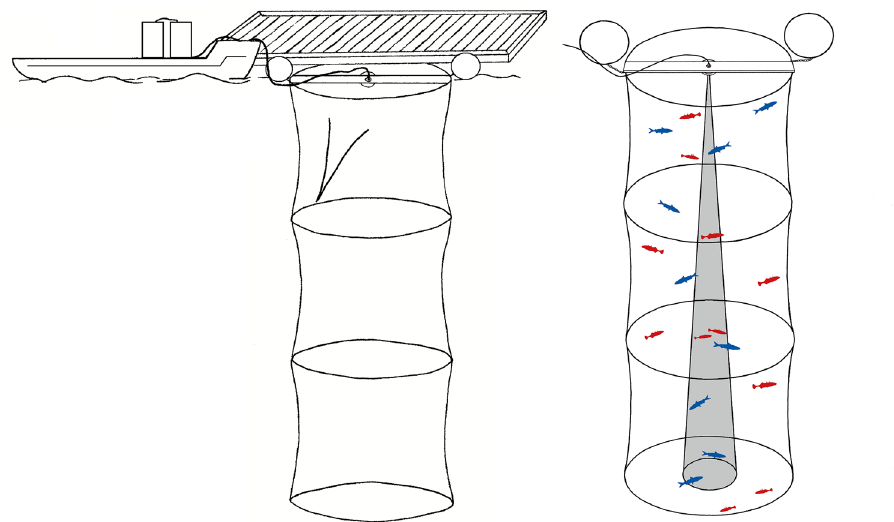
Figure 1. Left: experimental setup including boat with two tanks where the EK 80 wide band transceiver and a laptop were stored during the experiment and the mesocosm (6 × 2.3 m) attached to a floating pontoon. Right: mesocosm stocked with free swimming whitefish (blue) and sticklebacks (red), which are depicted together but were sampled separately for data collection. The cone (in grey) represents the true to scale sound cone emitted by the ES-120-7C transducer with an opening angle of 7°. Note that fish are not true to scale due to their small size. Drawings by Leonie Kneipp, LKdraw.